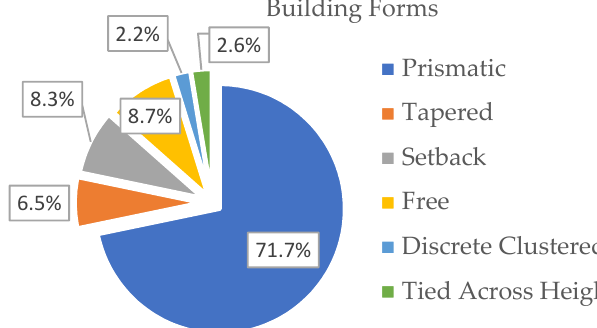
Figure 4. Analysis of selected tall buildings by building form.